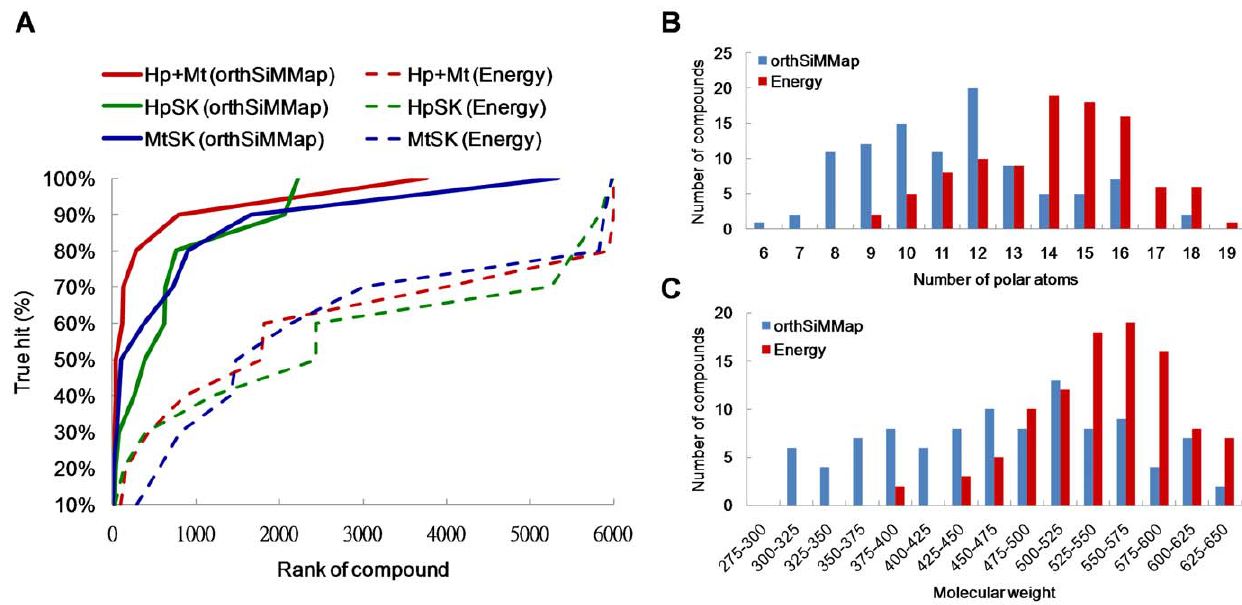
Figure 7. Performance of CoreSiMMap method on apo-form HpSK and MtSK. (A) True-hit rates of energy-based and CoreSiMMap scoring approaches. The CoreSiMMap scores (solid line) of adaptive inhibitors are significantly better than the energy-based scores (dashed line) for the 6000 top-ranked compounds by combining the Maybridge and NCI databases. (B) Distribution of number of polar atoms. (C) Molecular weights of top 100 compounds from CoreSiMMap scores and energy-based scores.